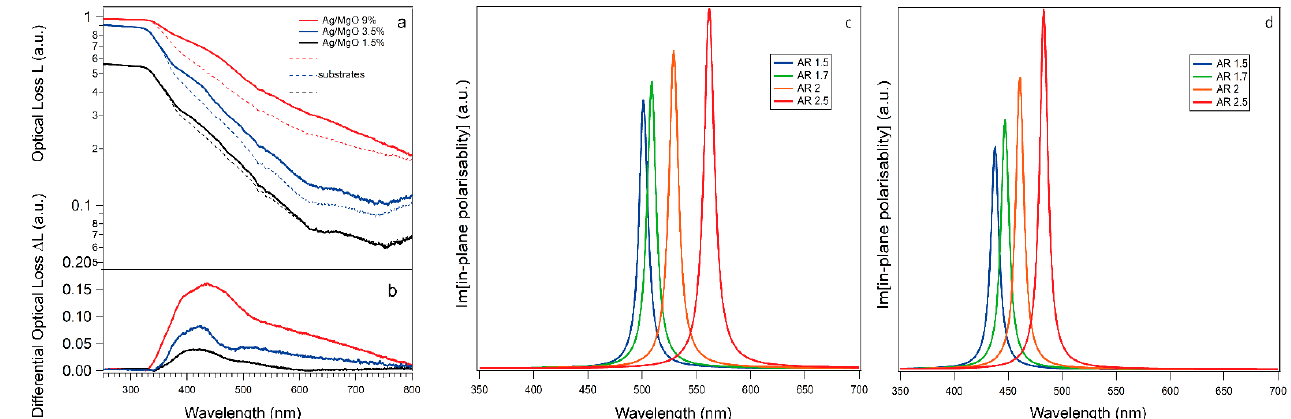
Figure 6. ( a ) Optical loss spectra of Ag/MgO NPs at different coverages levels. ( b ) Differential optical loss spectra of samples with different coverages of Ag/MgO NPs. The differences in signal intensity of L sub (and therefore the corresponding L) for different samples may arise from small variations in contaminants (e.g., carbon), humidity and roughness. ( c ) The imaginary part of the calculated in-plane polarizability for Ag NPs having different aspect ratios embedded in a MgO matrix with refractive index n = 1.7. ( d ) The imaginary part of the calculated in-plane polarizability for Ag NPs having different aspect ratios embedded in a MgO matrix with refractive index n = 1.4. Only the in-plane component of the polarizability has been computed due to the s-polarization of the light